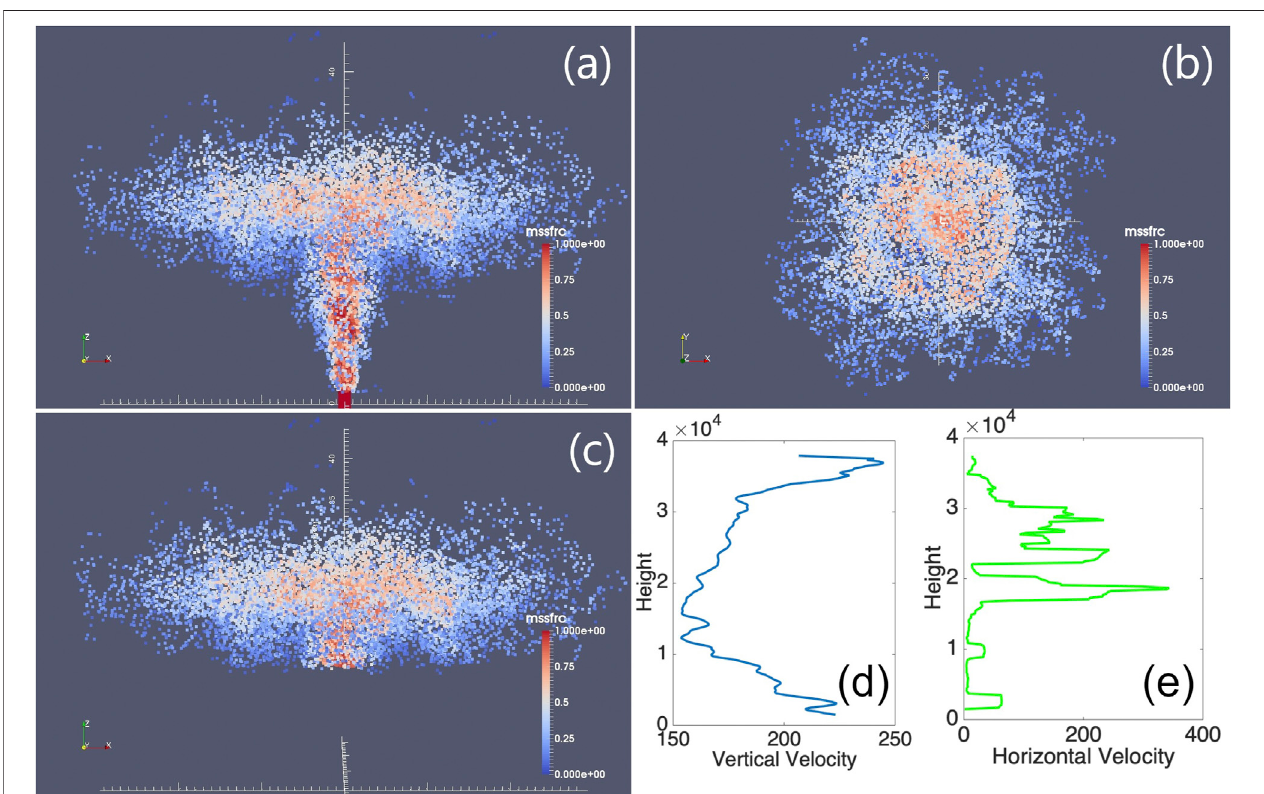
FIGURE2| Volcanoplumefrom3Dplume model.Allparticlesinthepicturesareofphase2(particleofphase1hasbeen removed)at 600 s after eruption,atwhich time, the plume has already reached the plume height and started spreading radially. (A) is the front view of the whole plume. (B) is the top view of the plume. (C) is the front view of the initial ash cloud, which is essentially a portion of the whole plume whose elevation is higher than a given threshold (in this picture is 15 km). Particles are colored according to mass fraction of erupted material. Red represents high mass fraction while blue represents low mass fraction. (D) is the average vertical velocityoftheplume.Atelevationsbelow15 km,theaverageverticalvelocitydecreases.Atelevationshigherthan15 km,theaveragedverticalvelocitystartsincreasing. (E) is the average horizontal velocity of the plume. Theaveraged horizontalvelocity becomes obviously larger when elevation is higher than15 km. So there fl ection point is somewhere around 15